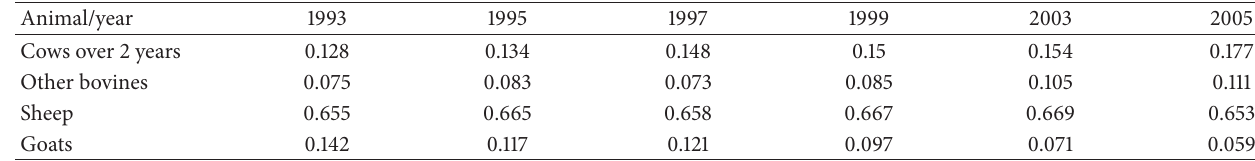
Table 5: Proportion of total livestock numbers estimated in Castelo de Vide.